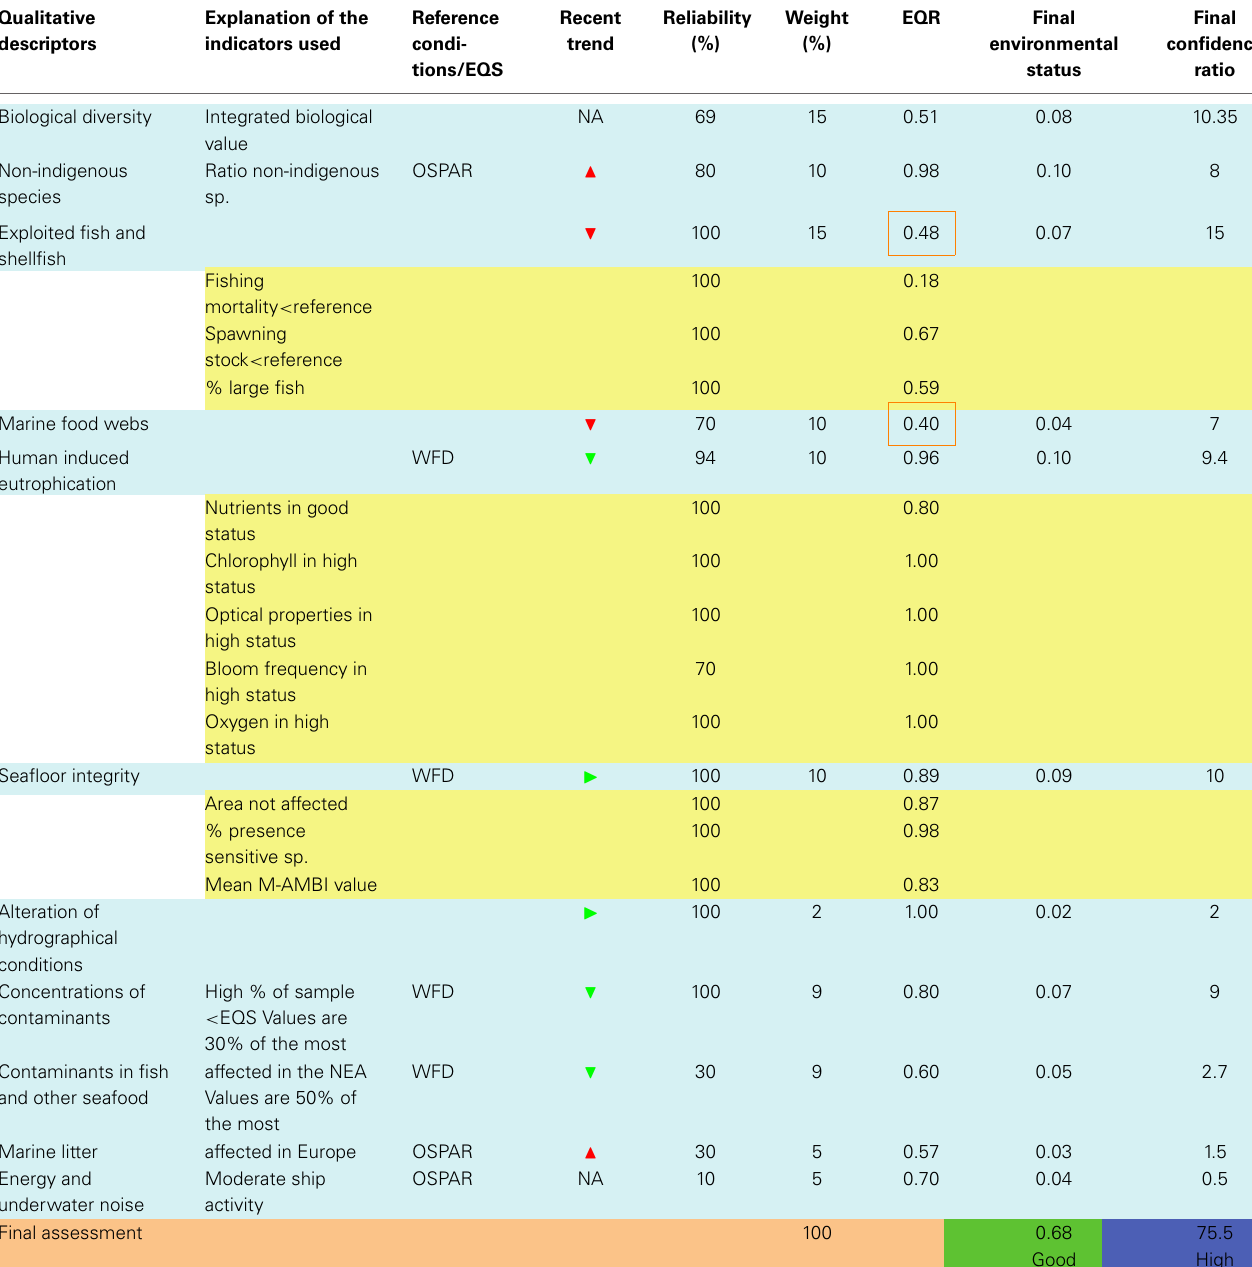
Table 5 | Example of an assessment of the environmental status, within the Marine Strategy Framework Directive, in the Basque Country offshore waters (Bay of Biscay) (modified from Borja et al.,